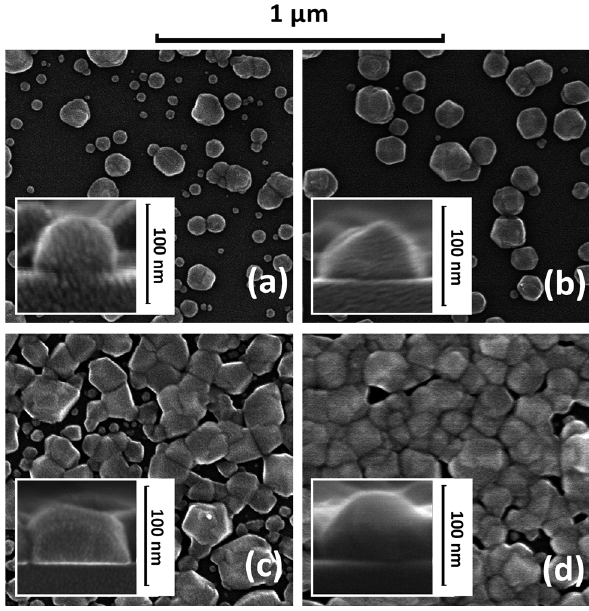
Figure 1: Plan-view SEM images of the Cd 0.9 Zn 0.1 O NPs grown on semi-insulating GaAs substrates with increasing growth time and surface coverage. (a) 90 s (growth time) – 25% (coverage), (b) 180 s – 32%, (c) 225 s